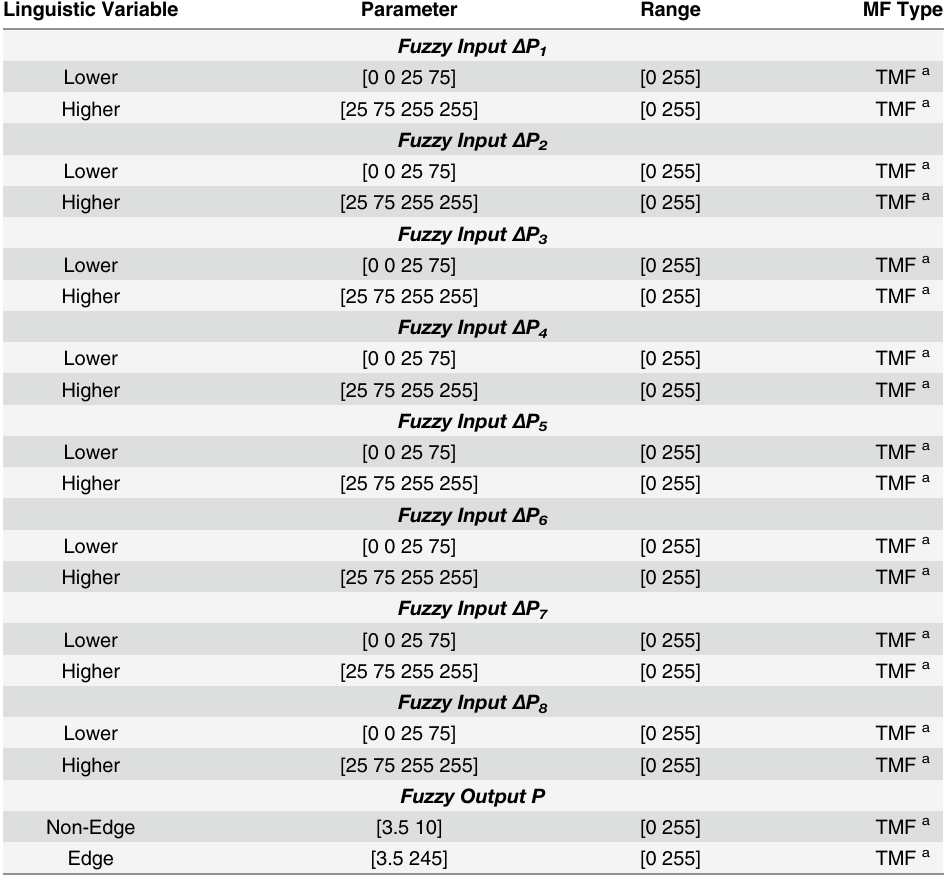
Table 1. Parameters and terminologies of input and output fuzzy